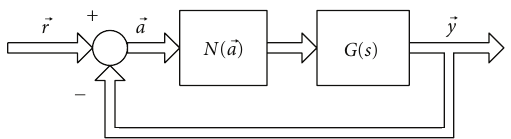
Figure 1: A general block diagram of nonlinear multivariable feed- back control